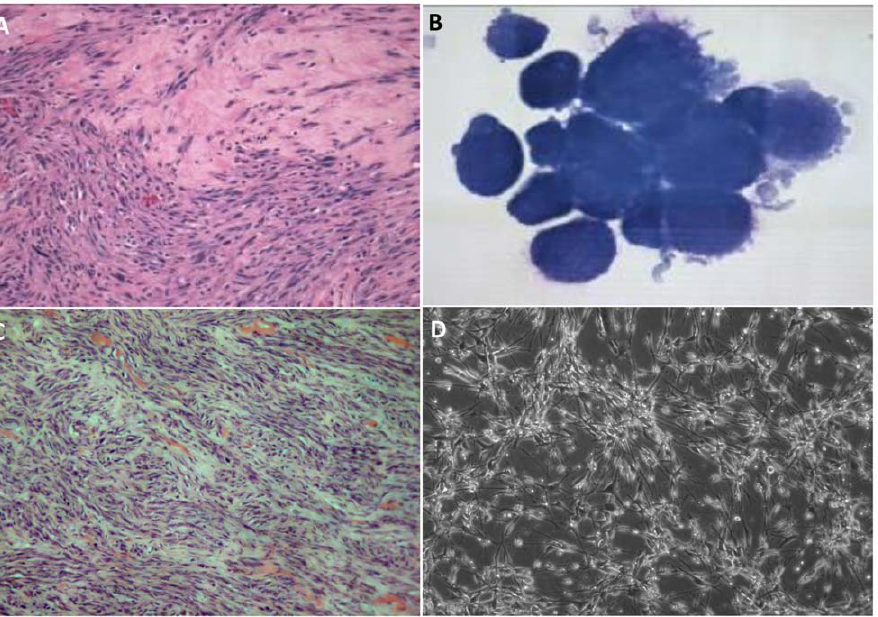
Figure 1. Imaging of STSA-1 tumors (A, C) and canine soft tissue sarcoma cells (B, D). ( A ) Histologic section of a canine soft tissue sarcoma from the limb of a golden retriever dog, hematoxylin and eosin stain (H&E, 6 200 magnification). ( B ) Cytology of canine soft tissue sarcoma cells STSA- 1 isolated from a subcutaneous mass on a golden retriever dog, Wright-Giemsa stain ( 6 1000 magnification). ( C ) Canine soft tissue sarcoma STSA-1 xenograft, right flank, athymic nude mouse (H&E, 6 200 magnification). ( D ) Transmitted light microscopy of uninfected STSA-1 cells in MEM-C culture ( 6 100 magnification).